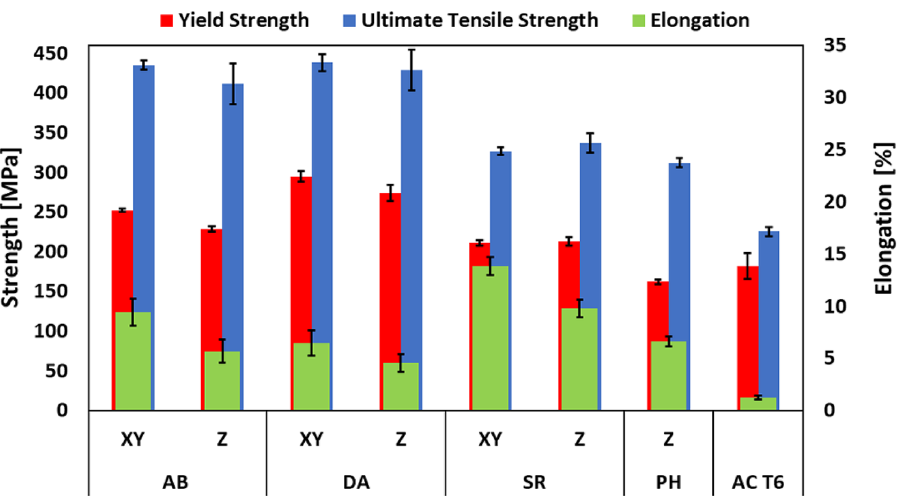
Figure 1. Tensile properties of LPBF-processed AlSi10Mg with conditions AB, DA, SR, PH, and their respective building orientations (horizontal (XY), vertical (Z)). Tensile properties of reference condition AlSi10Mg As-Cast